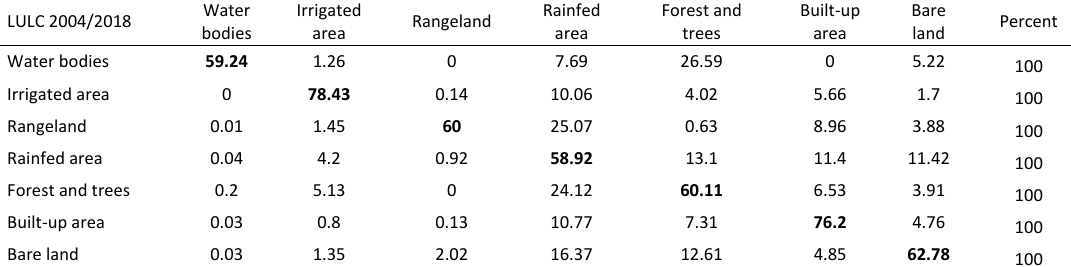
Table 6e: Probability of transition class for LULC 2004-2018 (round three)